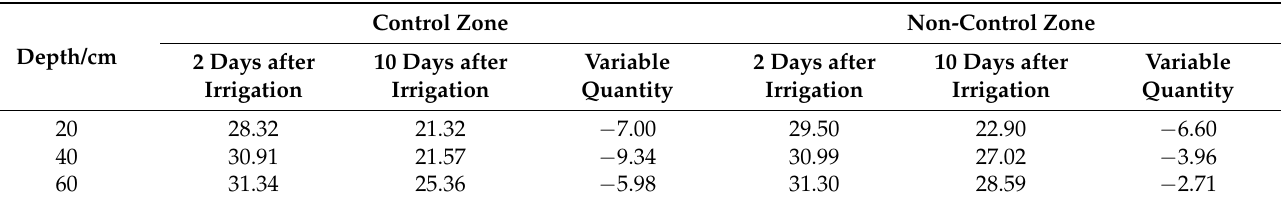
Table 1. Soil moisture content and its variable quantity at different depths in the control and non- control zones 2 days and 10 days after irrigation (unit: